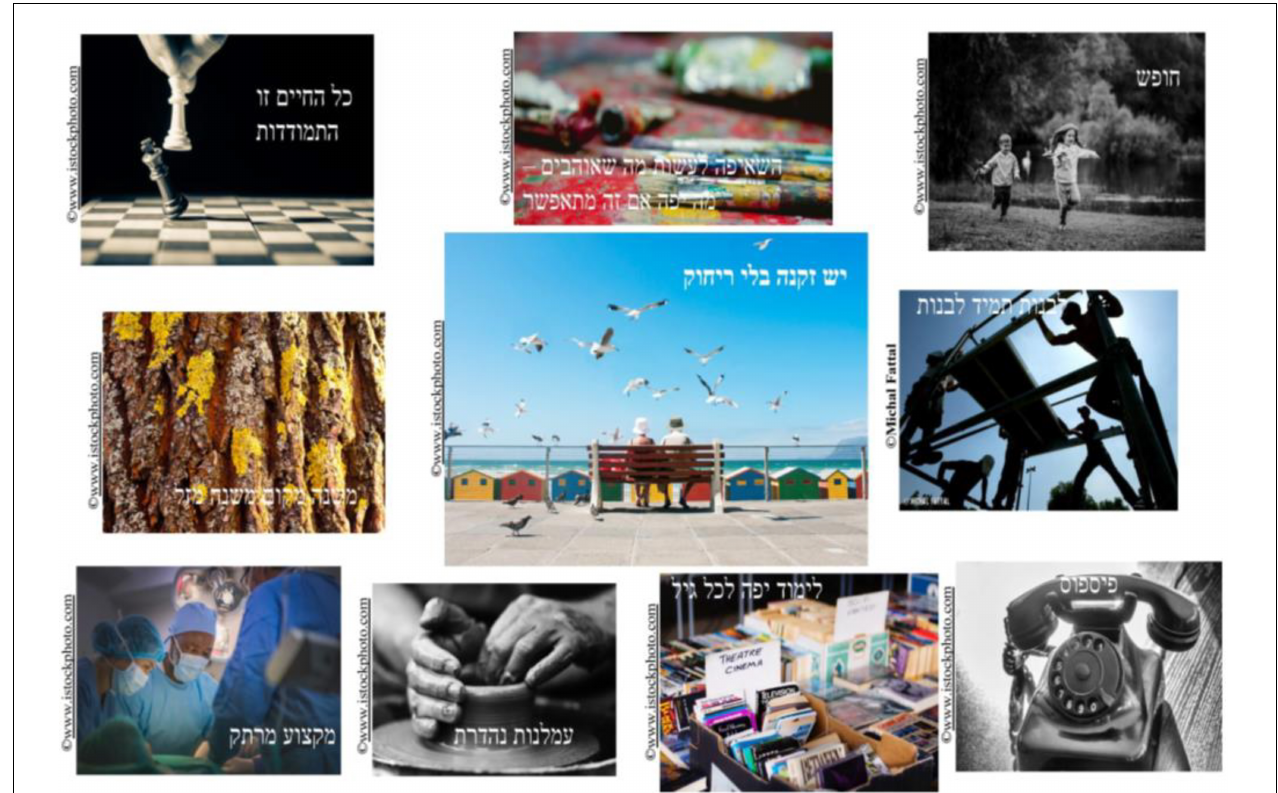
FIGURE 3 | Rivka’s photocollage.